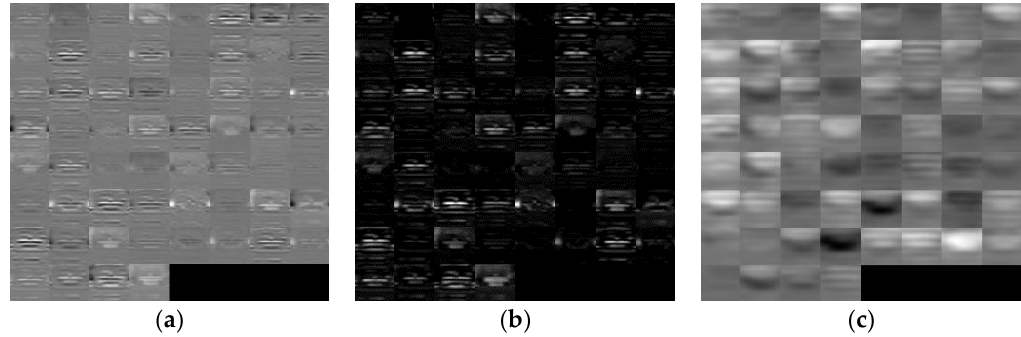
Figure 5. Example result of CNN’s layer visualizations: ( a ) Conv_2 Layer Visualization, ( b ) Maxpool_1 Layer Visualization, ( c ) Conv_5 Layer Visualization.